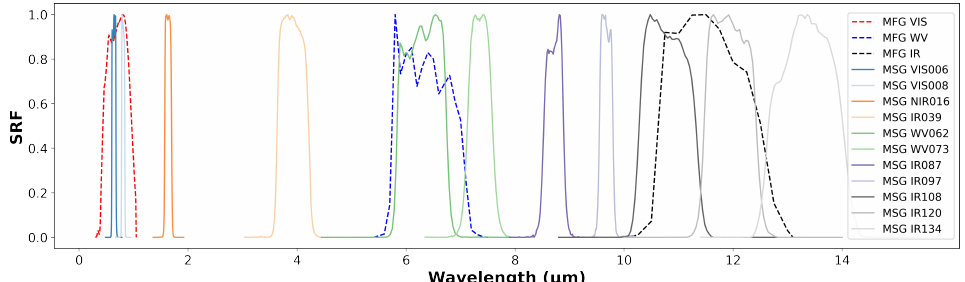
Figure 3. Timeline of different series of Meteosat satellites. The black rectangular box highlights the overlap period of MFG and MSG (2004–2006).